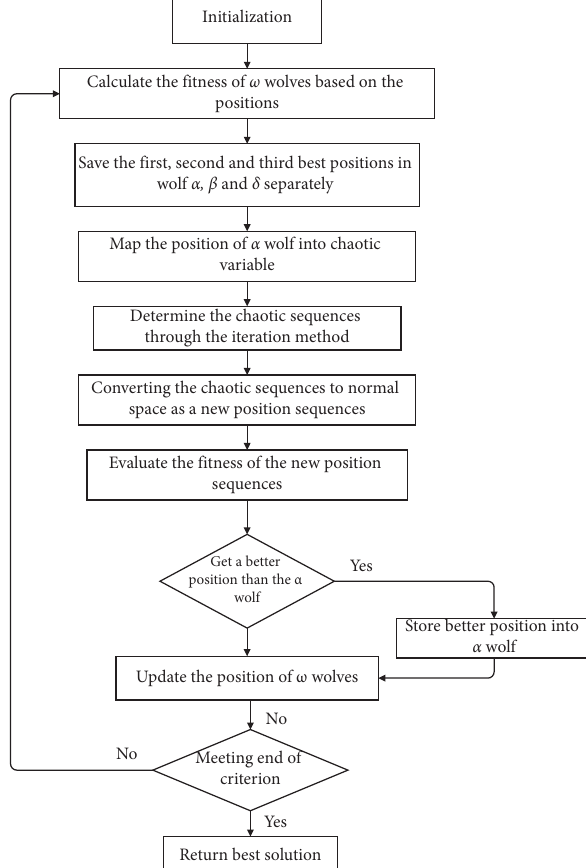
Figure 8: Grey wolf algorithm flow chart [41].